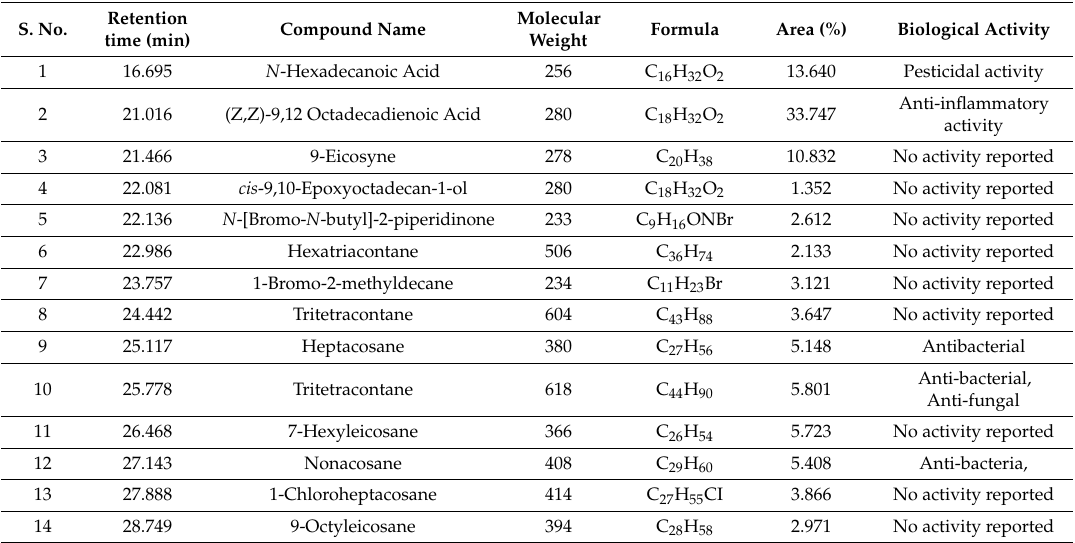
Table 3. Major bioactive compounds identified in the ethyl acetate mycelium extracts of B. bassiana -28 using Gas Chromatography-Mass Spectrometry analysis.